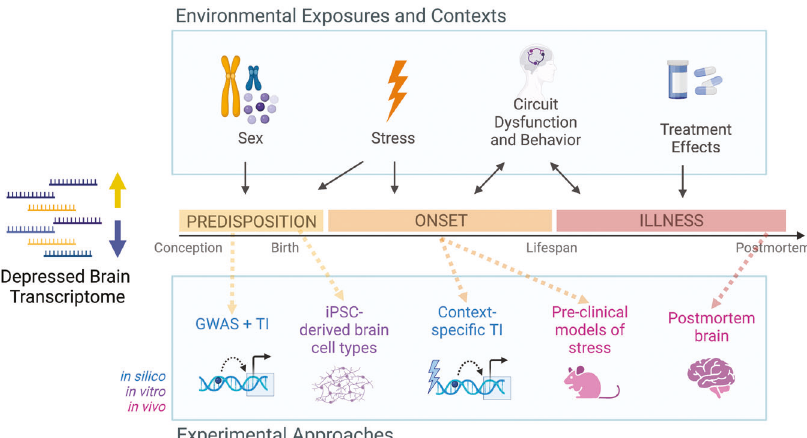
Fig. 1 Conceptual framework for exploring transcriptional dynamics of MDD in the brain. Transcription dysregulation associated with depression is dynamic from predisposition to onset to illness; it is in fl uenced by environmental exposures, contexts, and genetics, and can be studied from a variety of experimental approaches. GWAS genome-wide association study, TI transcriptomic imputation, iPSC induced pluripotent stem cells. Created with